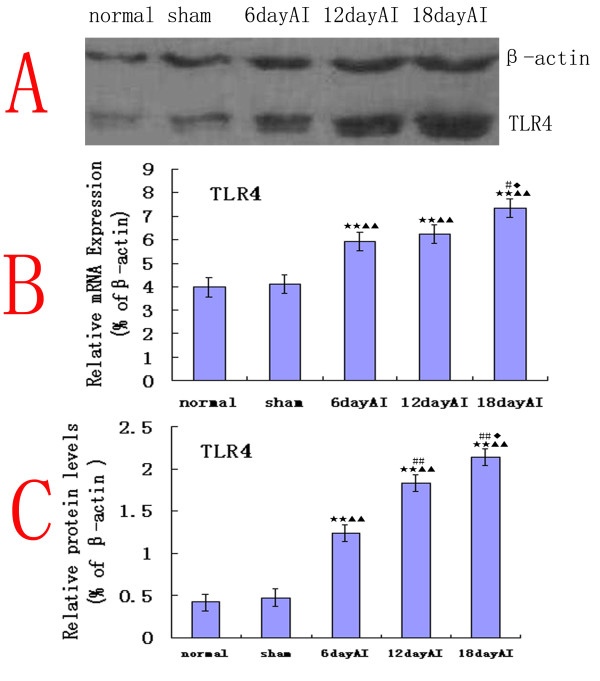
TLR4 expression increases in the bone cancer pain model. (B) Real-time quantitative RT-PCR analyses of mRNA temporal expression of TLR4 in rat lumbar spinal cord. The relative levels of spinal TLR4 mRNA significantly increased on days 6, 12 and18 (n = 4, ANOVA1w, P < 0.01, post hoc Dunnett testing, df = 3, F = 1.17) after inoculation (AI) in bone cancer pain rats compared with sham-injected controls and normal rats. The level of gene expression was calculated after normalizing against β-actin in each sample and is presented as relative mRNA expression units. (A, C) The protein level of TLR4 detected by western blotting analysis in spinal cord. A significant up-regulation of TLR4 protein level (n = 4, ANOVA1w, P < 0.01, post hoc Dunnett testing, df = 3, F = 1.06) on the sixth day AI. The protein levels further increased at 12 and 18 days (P < 0.01) after inoculation compared with sham-injected controls and normal rats, respectively. Each data point represents at least three independent experiments. Values are presented as mean ± SEM. *P < 0.05, **P < 0.01 vs. normal group; ▲P < 0.05, ▲▲P < 0.01 vs. sham group; #P < 0.05, ##P < 0.01 vs. 6 day AI; ◆P < 0.05, ◆◆P < 0.01 vs. 12 day AI.